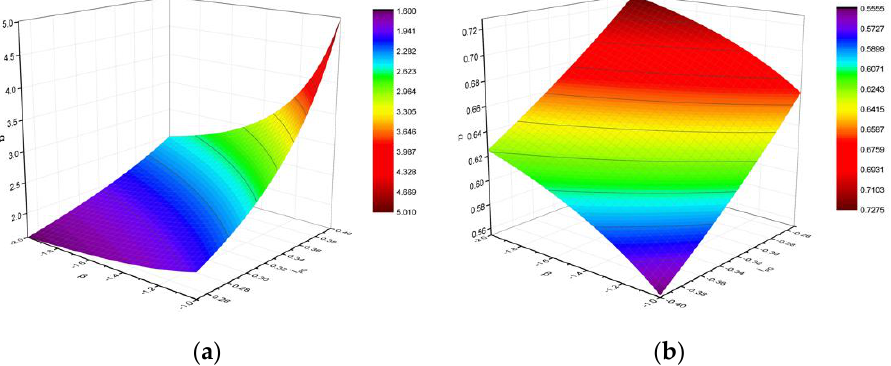
Figure 12. The range of transmission ratio, 𝑖 𝑜𝑒 , in the matching pattern a. ( a ) The transmission range 𝛼 of scheme 1; (b) The transmission range 𝛼 of scheme 3.